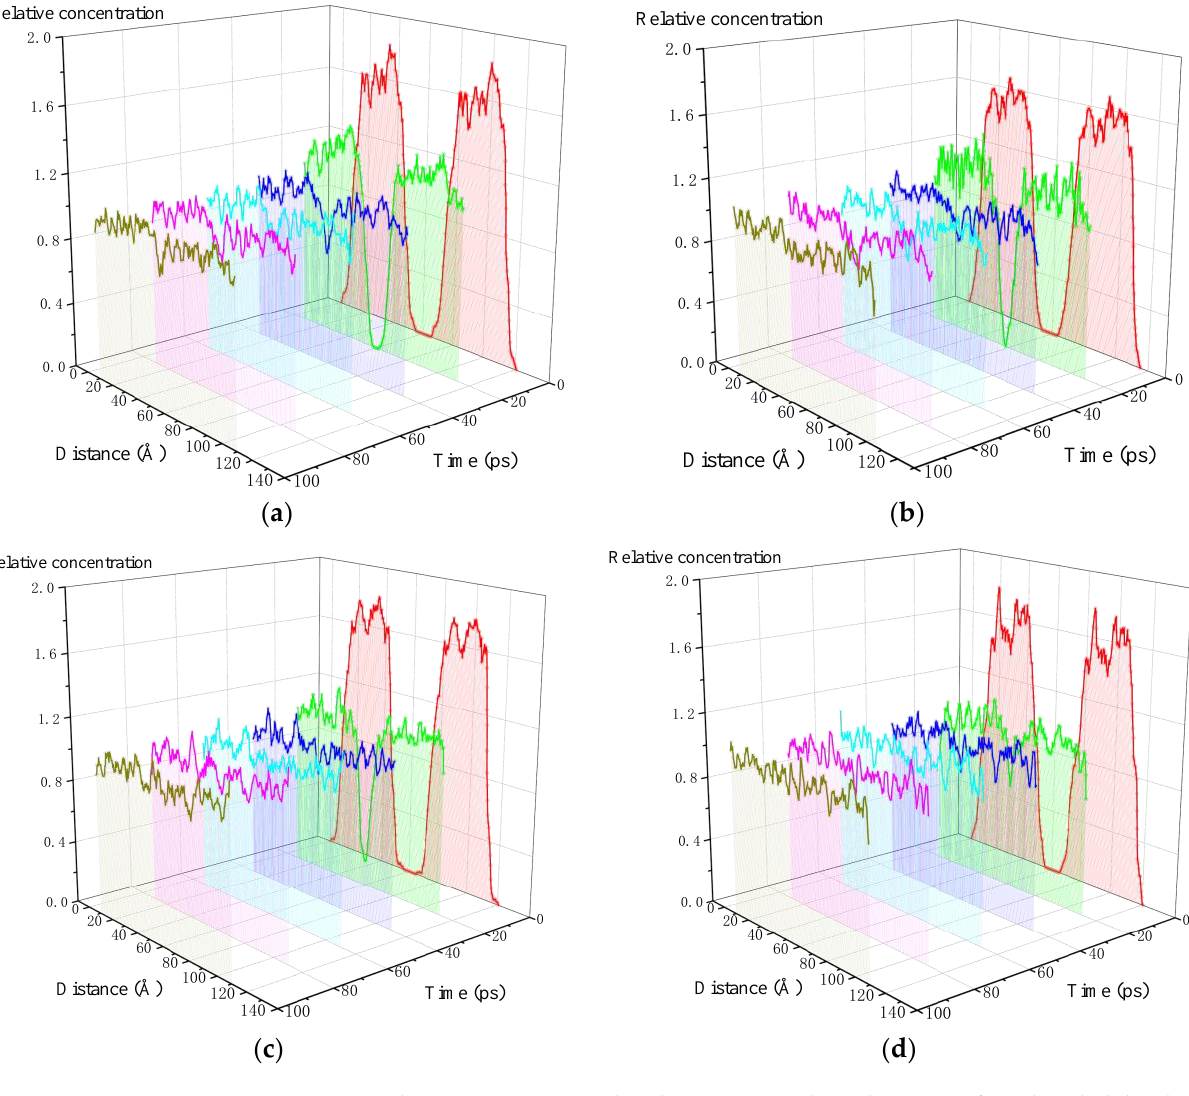
Figure 10. Relative concentration distribution curve along the z axis of aged asphalt binder with 1 nm crack: ( a ) 278.15 K; ( b ) 298.15 K; ( c ) 318.15 K; ( d ) 338.15 K.